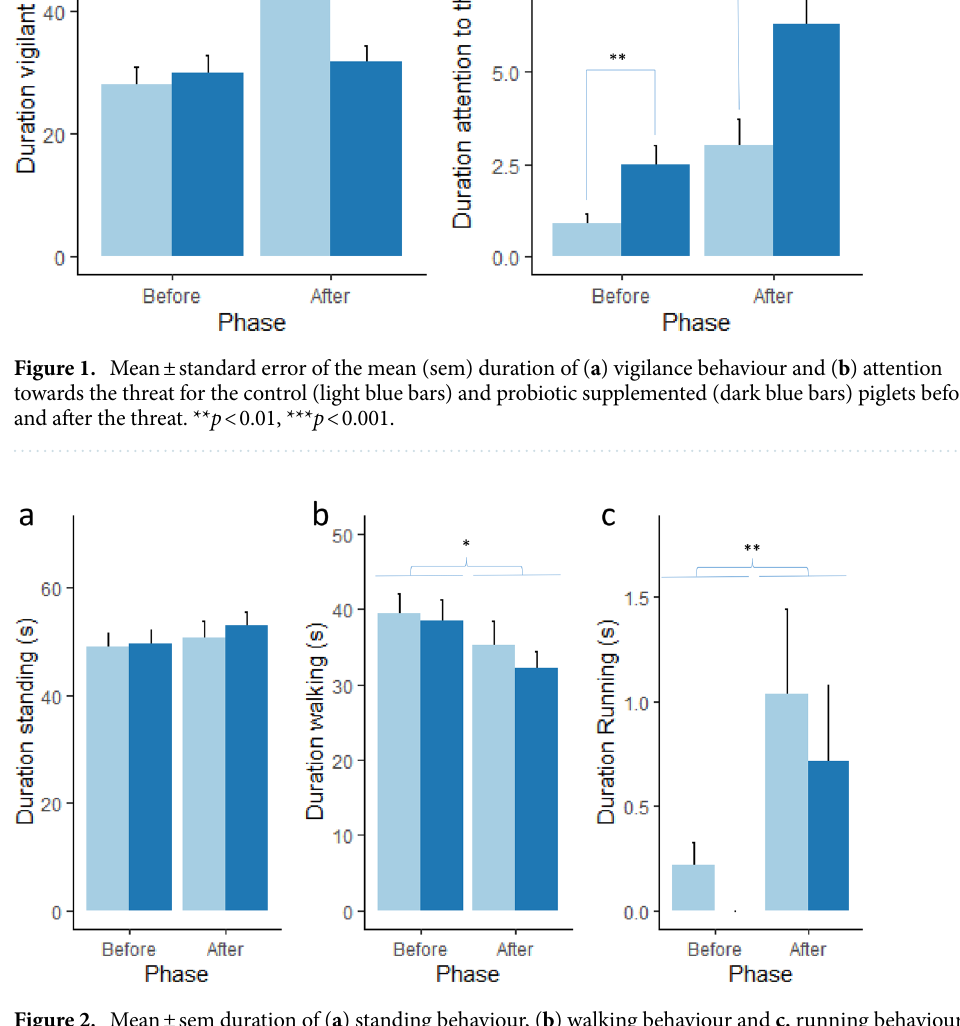
Figure 2. Mean ± sem duration of ( a ) standing behaviour, ( b ) walking behaviour and c. running behaviour for the control (light blue bars) and probiotic supplemented (dark blue bars) piglets before and after the threat. * p < 0.05, ** p <